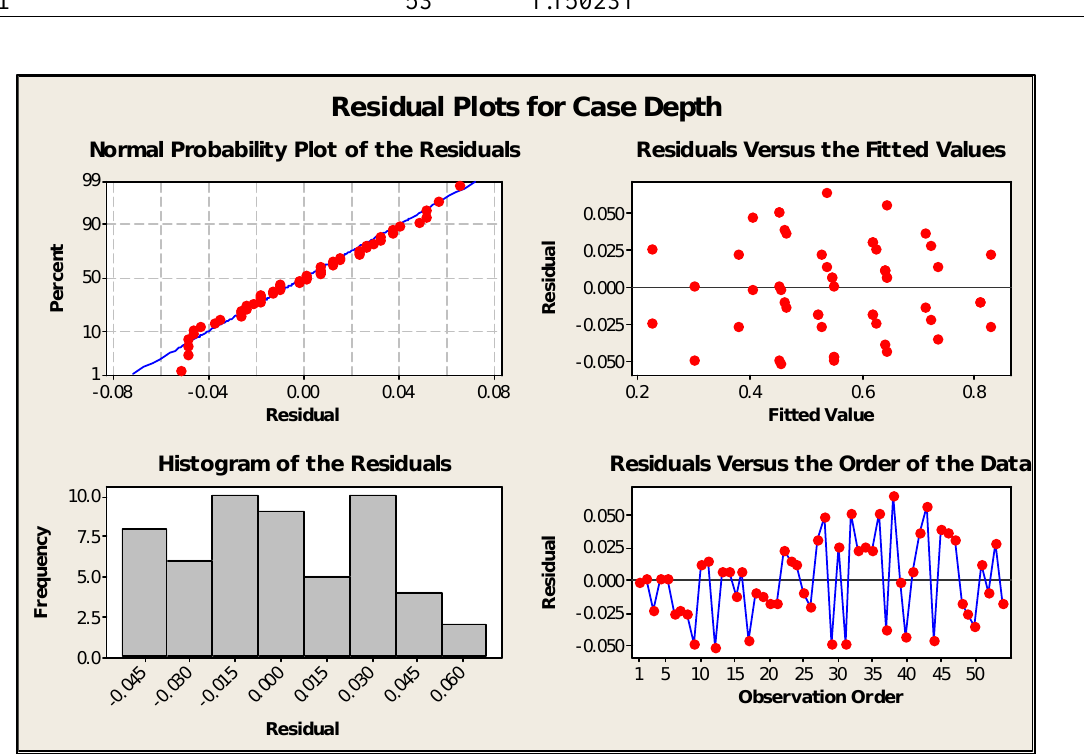
Fig. 2. Residual plots for Case